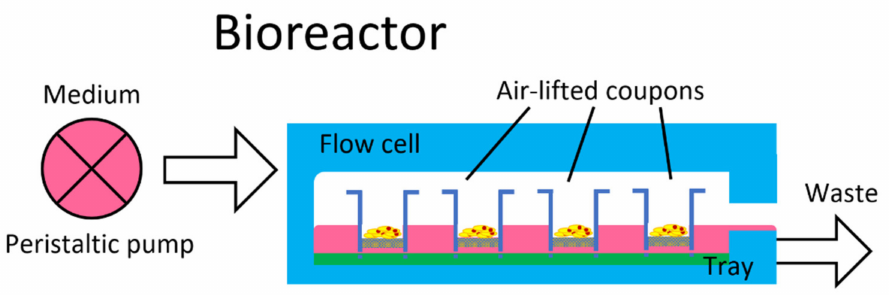
Figure 1. Functioning diagram of the coupon-bearing bioreactor. The peristaltic pump provides a constant flow of supplemented medium to the flow cells for the specified amount of time. The whole system is provided with a 5% CO 2 supplemented atmosphere.